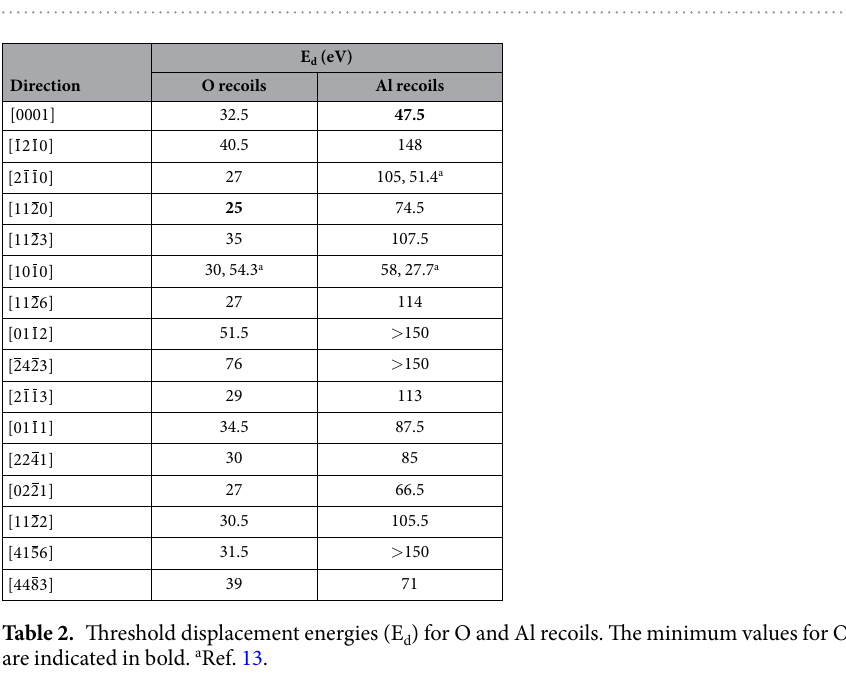
Table 1. Calculated lattice constant (Å), elastic moduli (GPa) and Poisson’s ratio ( σ ) for α -Al 2 O 3 . B: bulk modulus, G: shear modulus. E: Young's modulus. a Ref. 21. b Ref. 22. c Ref. 24. d Ref. 23.